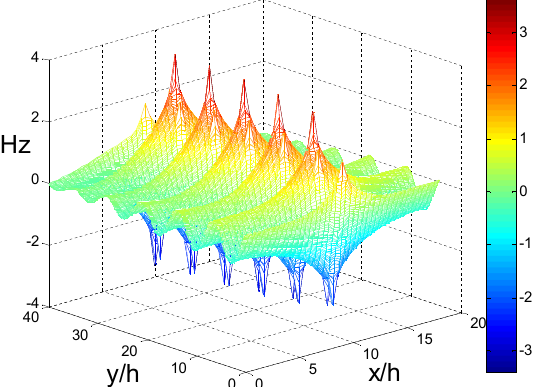
Figure 7. Near field propagation distribution representing the wavelength of 413 nm.